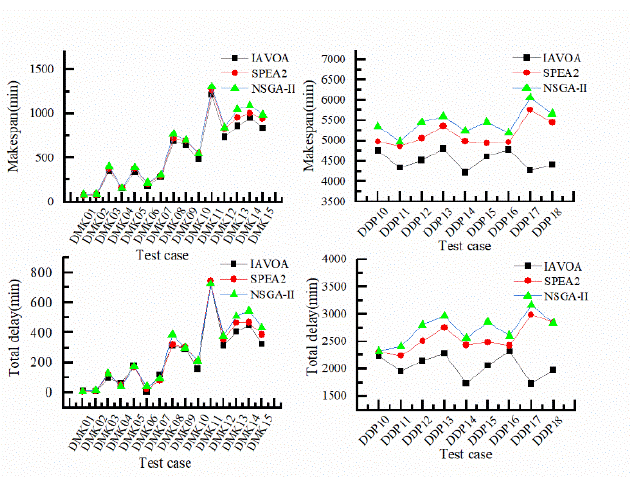
Figure 11. Line chart of the optimization problem values.